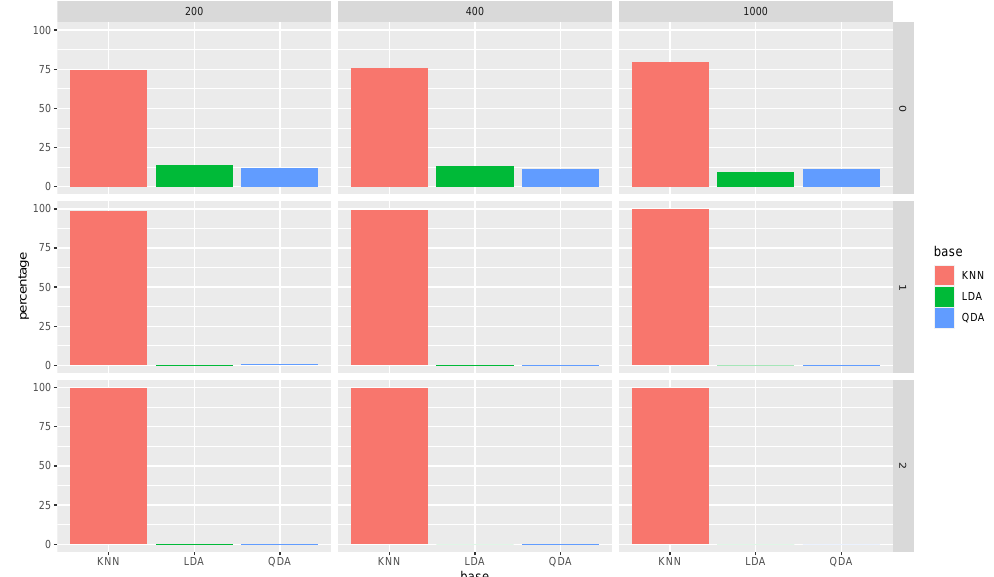
Figure 5. The average selected proportion for each base method for different sample sizes (corre- sponding to each column) and iteration number (corresponding to each row) in Model 3 (KNN).